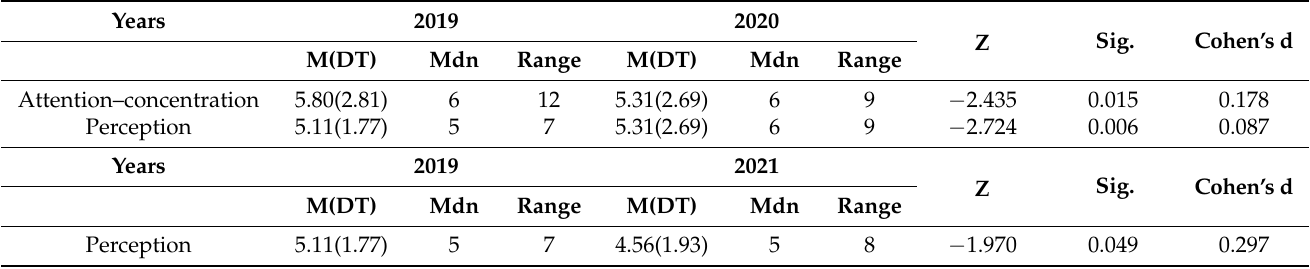
Table 6. Comparison 2019–2020/2019–2021. Age group ≥ 46 years ( n = 47). Wilcoxon Z Range test for related